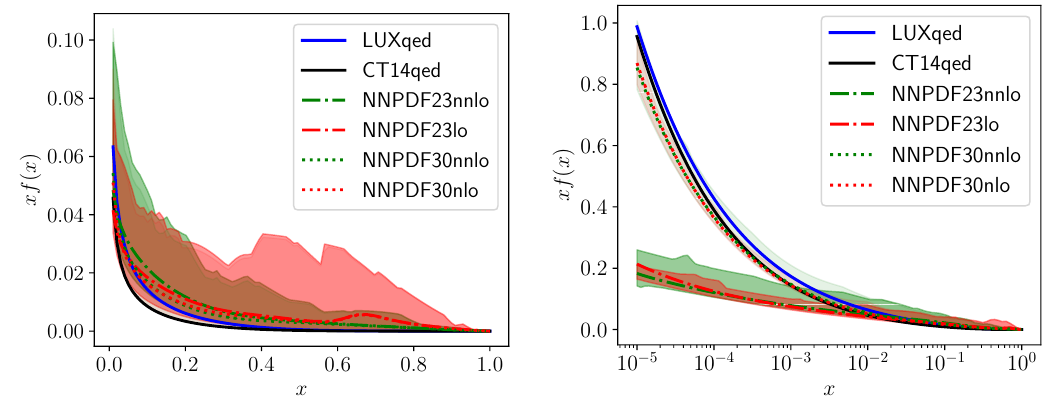
Figure 16 . Same as in (cid:12)gure 15 but for a scale of 1 TeV. The conclusion stands and the newest NNPDF sets are now in agreement with CT14 and LUXQED, within